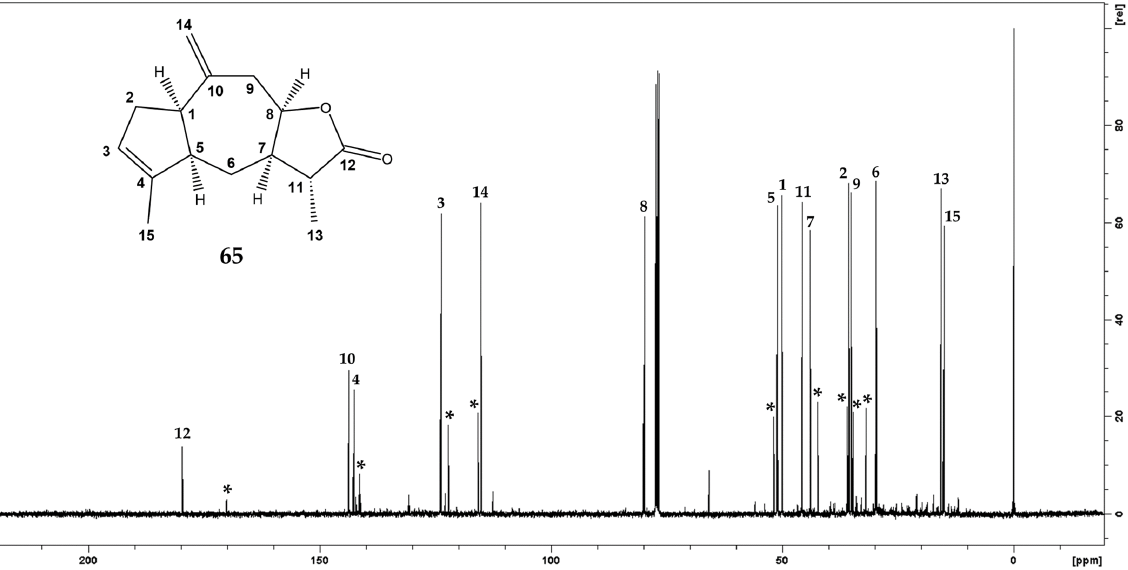
Figure 3. NMR 13 C spectrum of the MAE fraction 11 in CDCl 3 (125.77 MHz, at 300 K) in which two